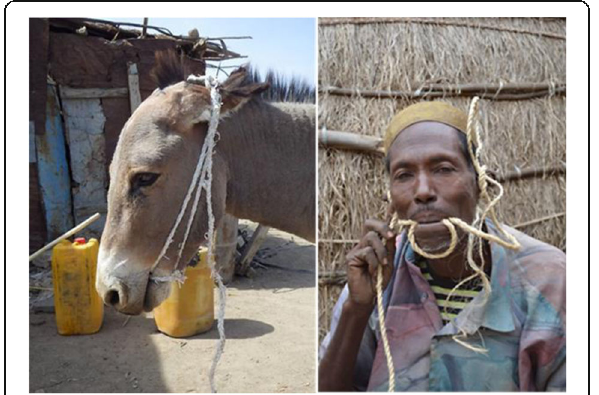
Figure 4 One of early training method of donkeys “ Tying jaw, ears and forelimbs ” in Afar communities, Ethiopia. Left: Area A, Right: Area B